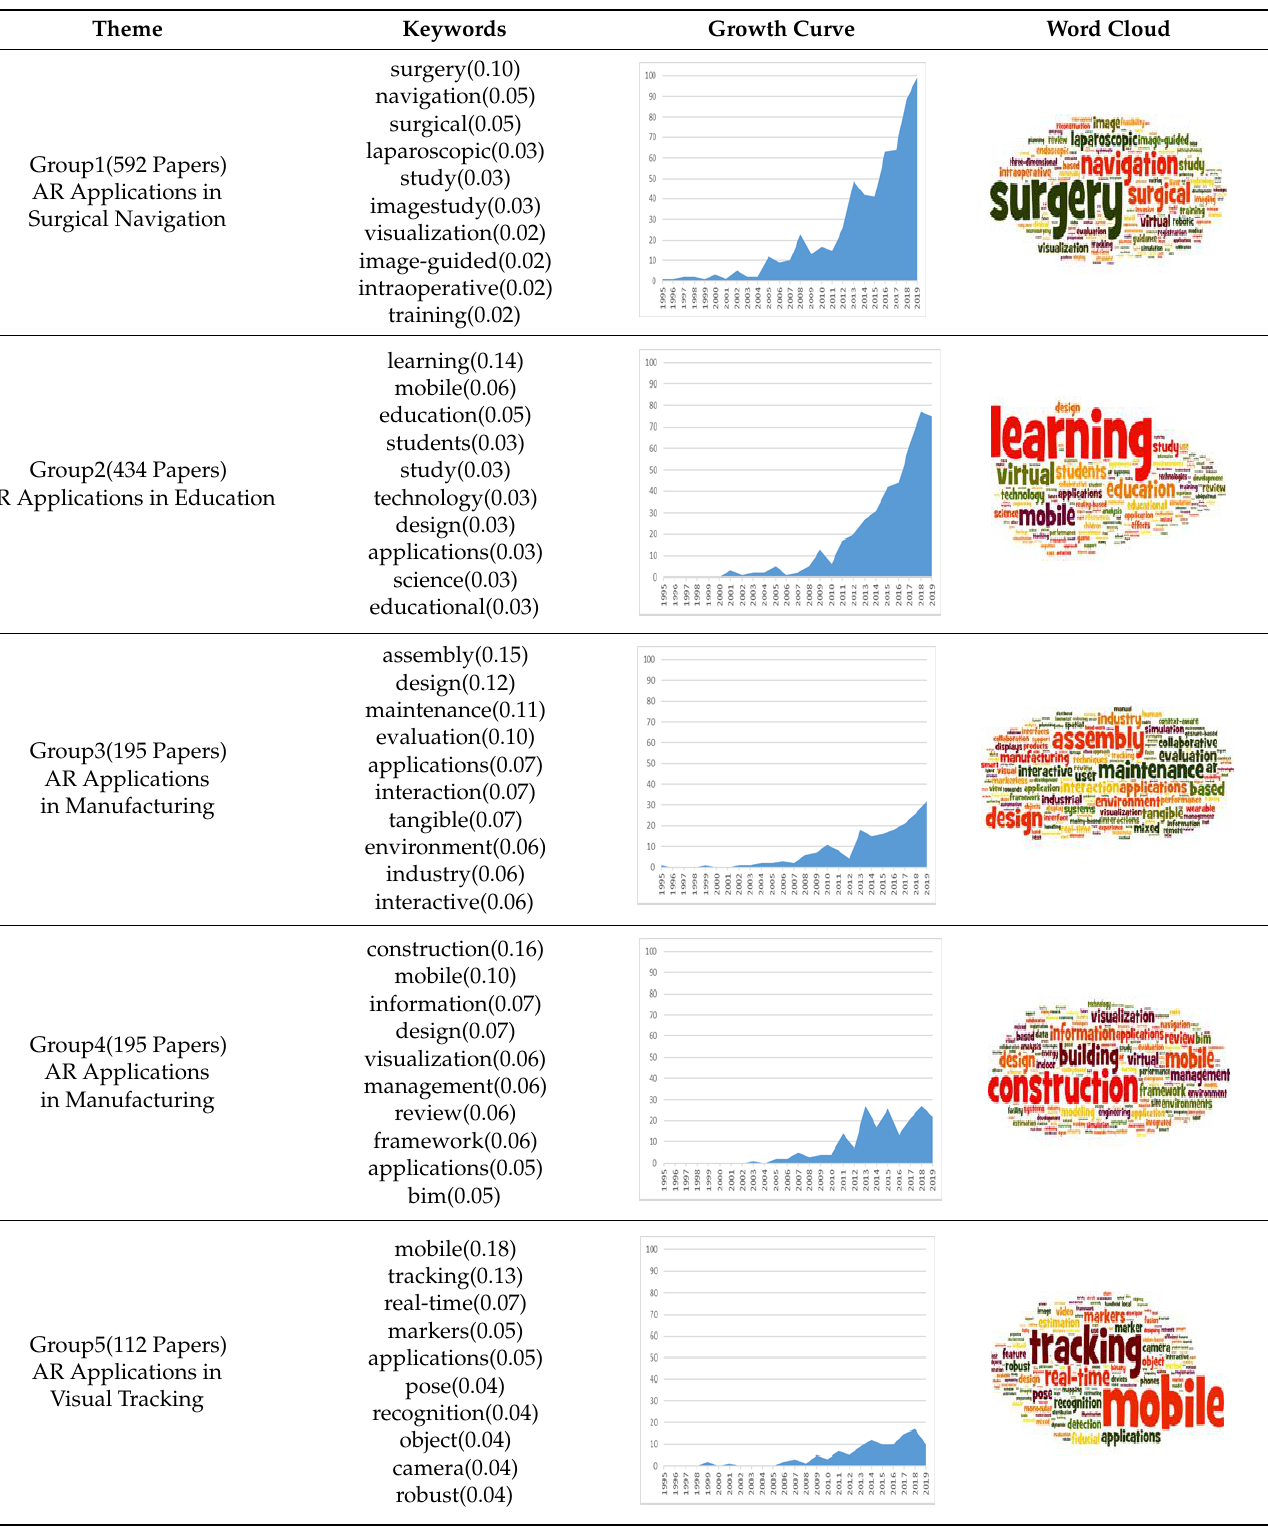
Table 2. Themes, number of papers, keywords, word cloud and growth curve of each identified group.